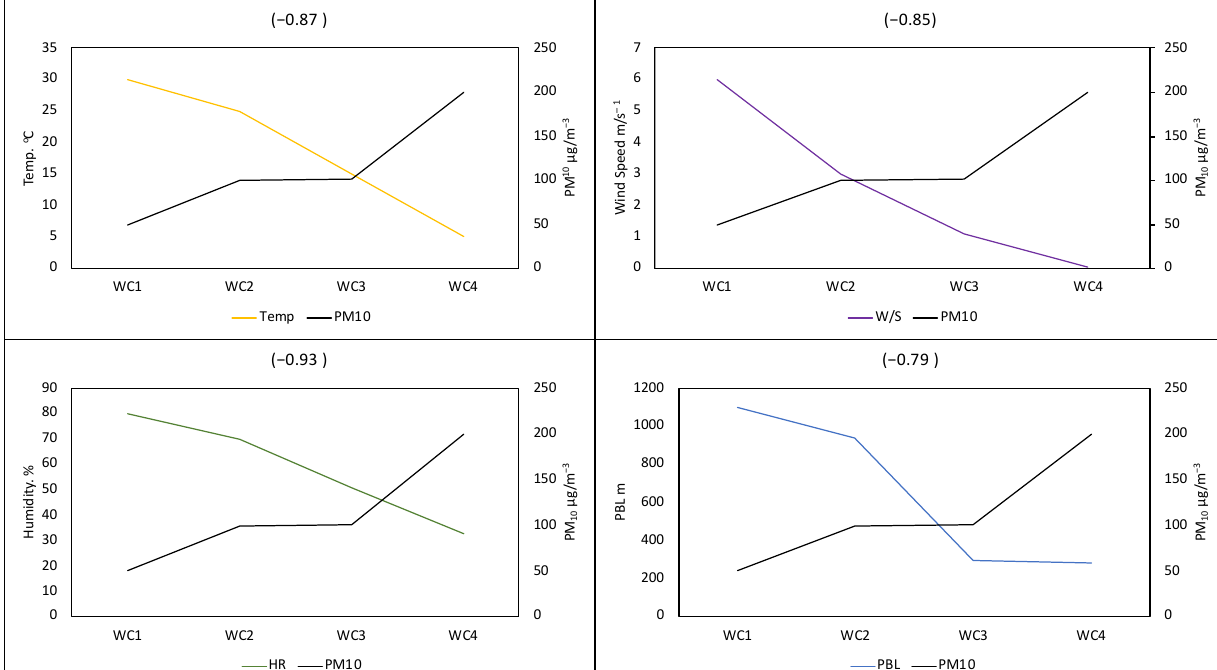
Figure 9. The correlation coefficient between PM 10 and the classified weather condition patterns.